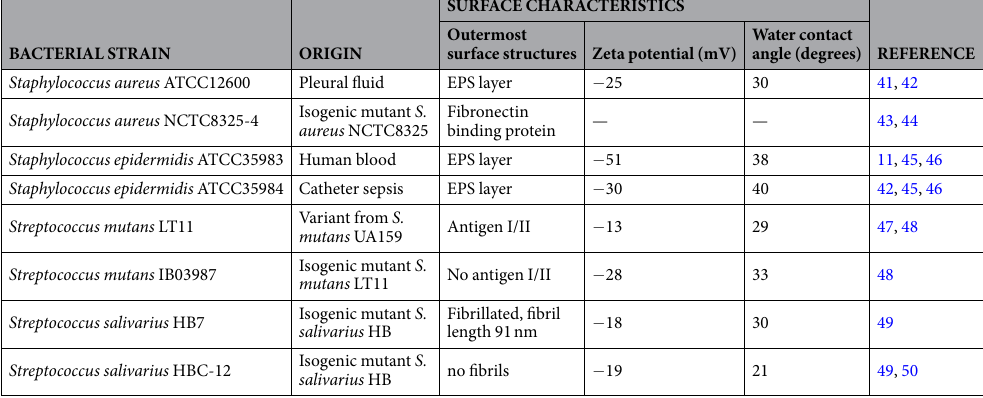
Table 2. Overview of the origin and relevant, known surface characteristics of the eight strains used in this study, arranged with each of the four species grouped